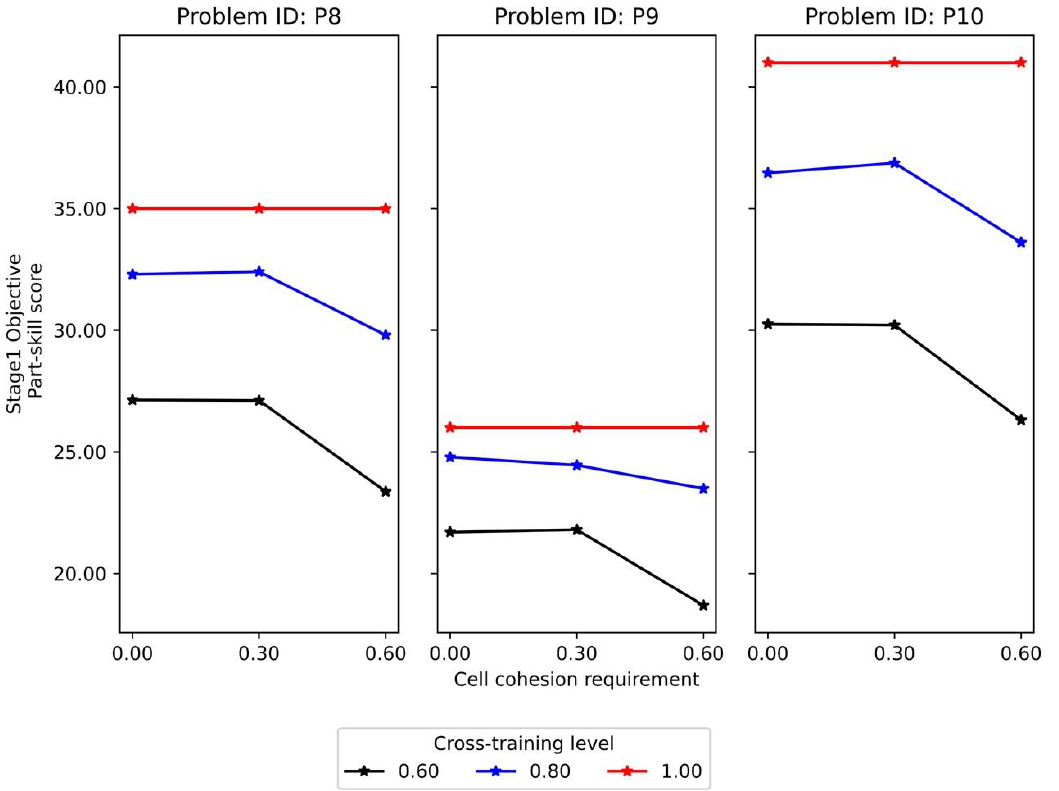
Figure 5. Interaction effects between cell-cohesion requirement and cross-training level on part-skill